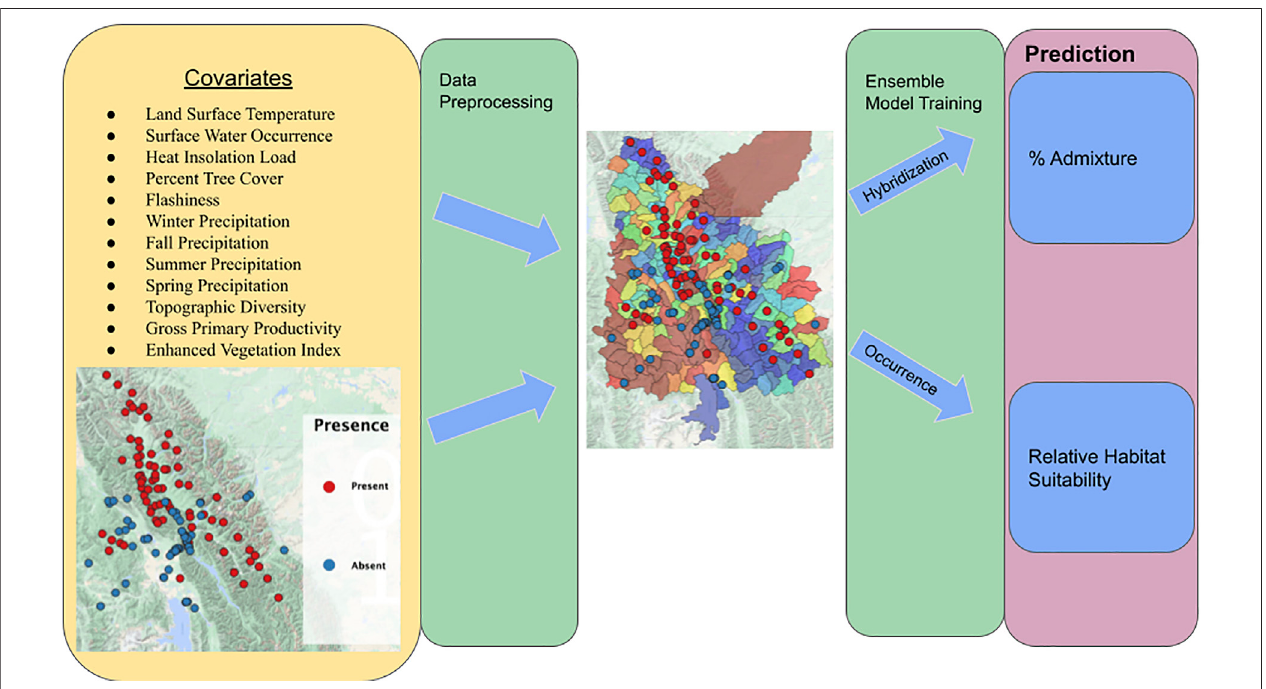
FIGURE 2 | Overall work fl ow, model inputs, and model outputs. Yellow box indicates model inputs. Green boxes indicate steps as referenced in the methods. Purple box indicates each model output. RBT presence and absence observation locations are denoted by respective red and blue points on the associated study area